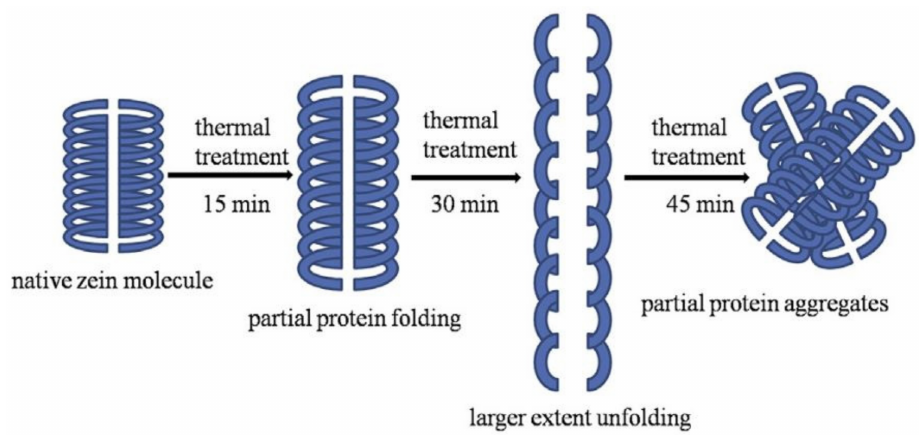
Figure 2. A schematic diagram of the potential mechanism of the three-step process involved in structural changes to zein following thermal treatment. Reproduced with permission from [30], ELSEVIER,